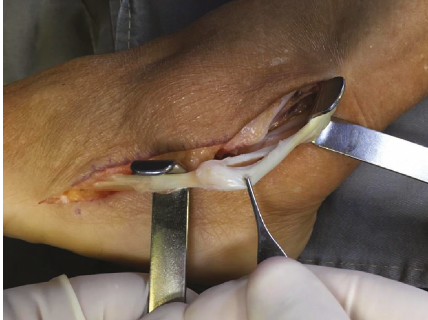
Figure 4: Patient II: extensive alteration of the PB tendon.